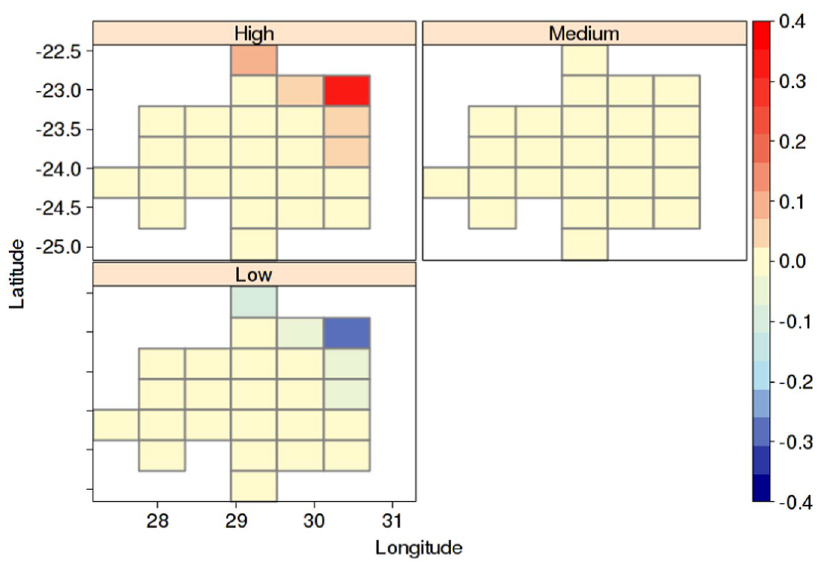
Figure 4. Self-organized map for malaria incidence rate anomalies (% per 1000 person-years) in Limpopo. Cells represent local municipalities of Limpopo, with coloured cells being Musina, Thulamela, Mutale, Greater Giyani, and Ba-Phalaborwa. Figure was made in R version 3.2.2